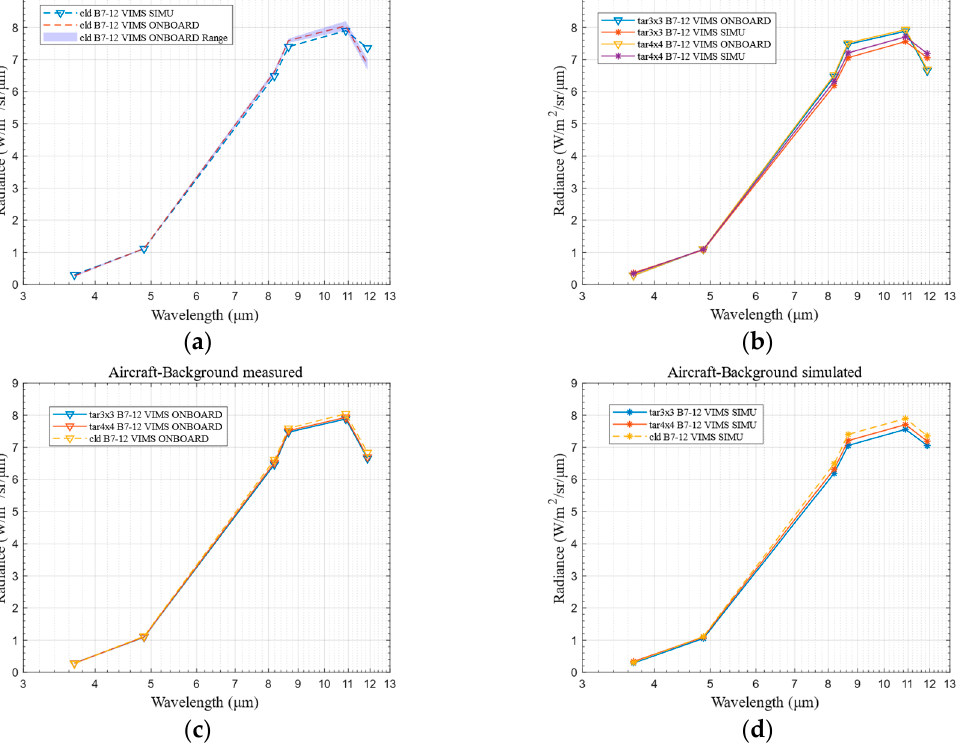
Figure 5. The comparison of the background and aircraft radiance spectra, ( a , b ) is the comparison of simulated and measured restored radiance, and ( c , d ) is the comparison of target and background radiance curves. Table 3. Simulation accuracy, target-background contrast calculation